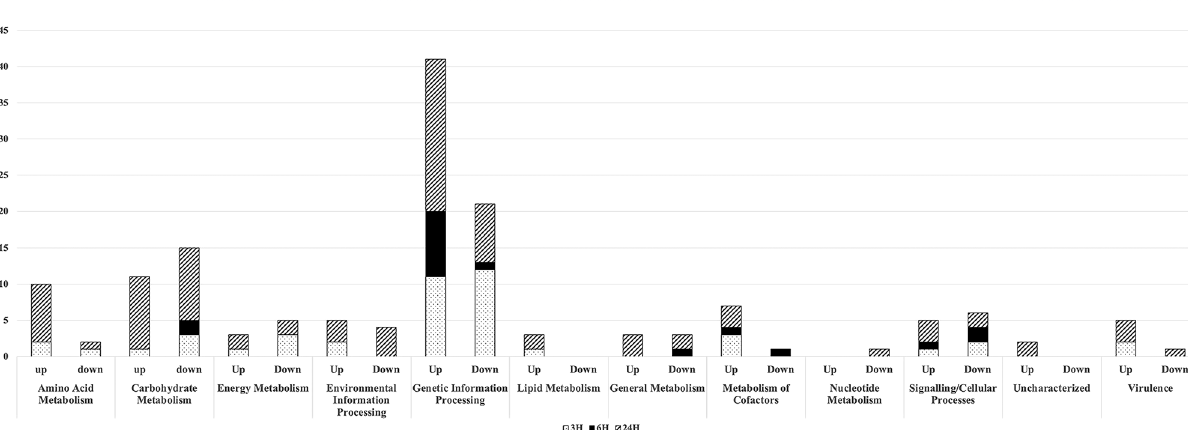
Figure 4. Percent difference in hla promoter activity (Luminescence) of mycolactone treatments from vehicle control.